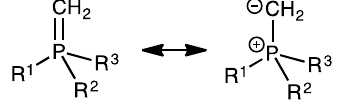
Figure 3. In-solvent (CH 2 Cl 2 ) M06/TZVP~SDD//BP86/SVP~SDD free-energy profile for the olefin metathesis reaction catalyzed by complex A ( A = PPh 3 here) using ethylene as substrate (energies in kcal/mol). The cis and trans modes (in black and green, respectively) correspond to the regioselectivity